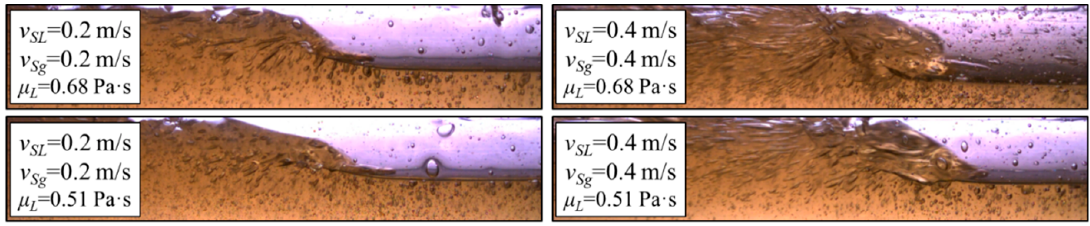
Figure 3. Deformation of entrained air by induced shear at slug front [16].